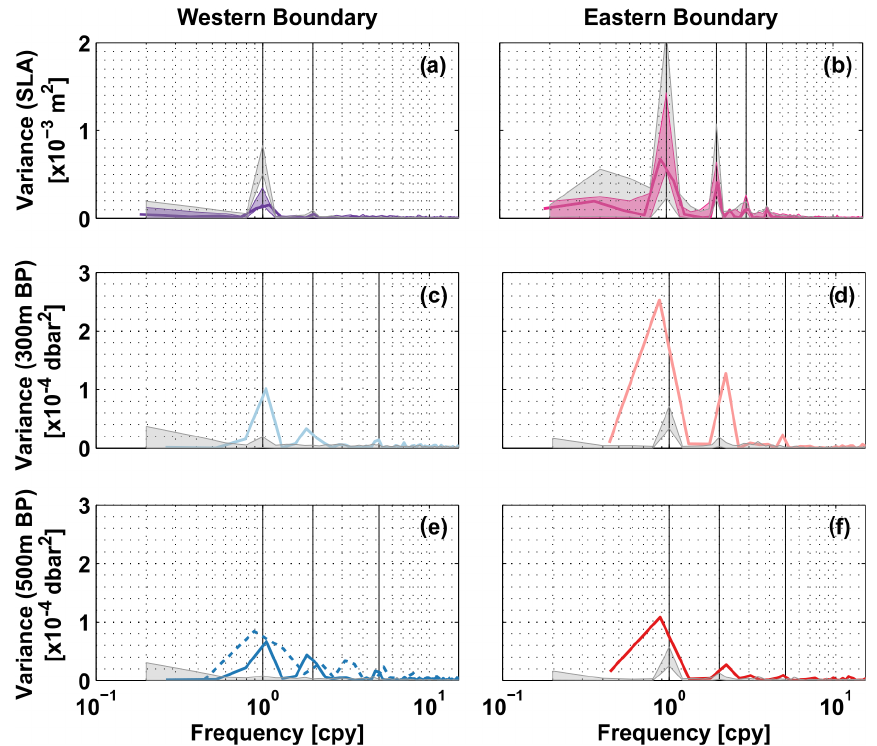
Figure 4. Periodograms of (a, b) SLA, (c, d) BP at 300m and (e, f) BP at 500m depth – from observations (coloured) and from the INALT01 model (grey). In panels (a, b) , solid bold curves show periodograms calculated from SLA data over the period 2013–2018. The transparent envelopes are an estimate of interannual variations: specifically, the minimum and maximum ranges of periodograms calculated for 5-year windows running through the full available period (1993–2018). In panels (c, d, f) , solid bold curves show periodograms calculated from the individual BP time series available at 11 ◦ S. In panel (e) , the solid curve represents KPO 1135 and the dashed curve KPO 1109 (two co- located sensors covering different periods; see Table 1). Grey shading in all panels gives the minimum and maximum ranges of periodograms for SLA and BP time series derived from the INALT01 model calculated for 5-year windows running through the full available period (1978– 2007). Frequency is given in “cycles per year”. Vertical black lines mark the frequencies of the annual and semi-annual cycles, as well as periods of 120 and 90d in panel (b) or 70d in panels (c–f)